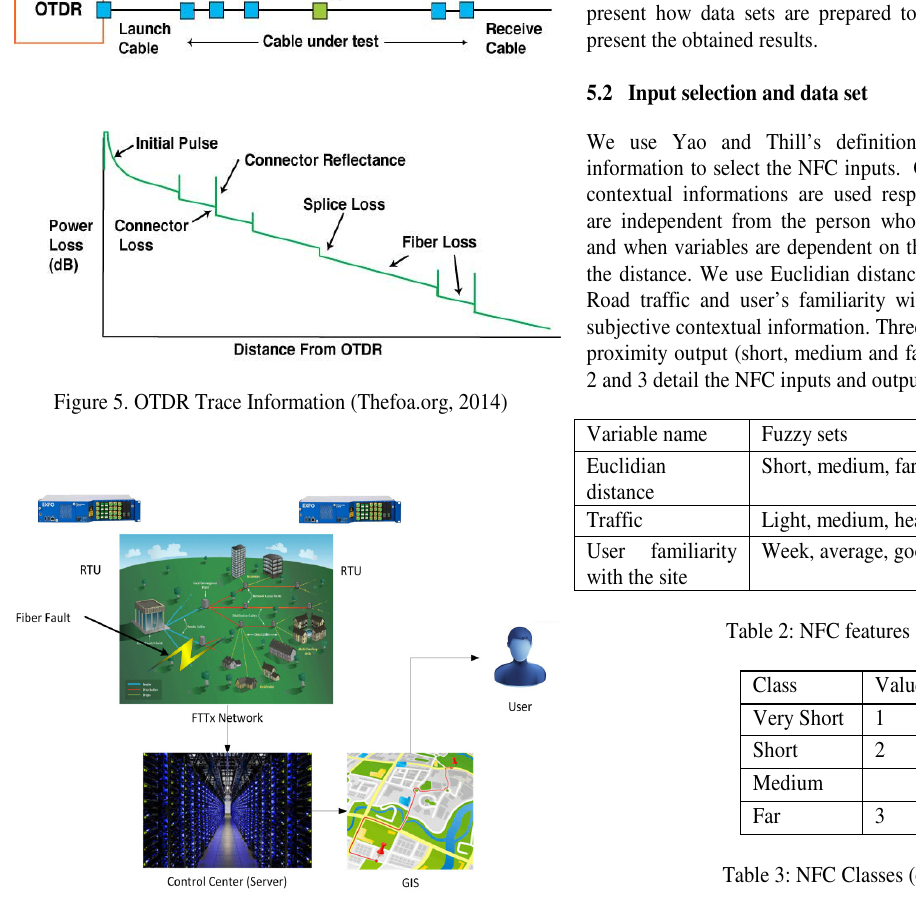
Figure 6. General architecture of RFTS